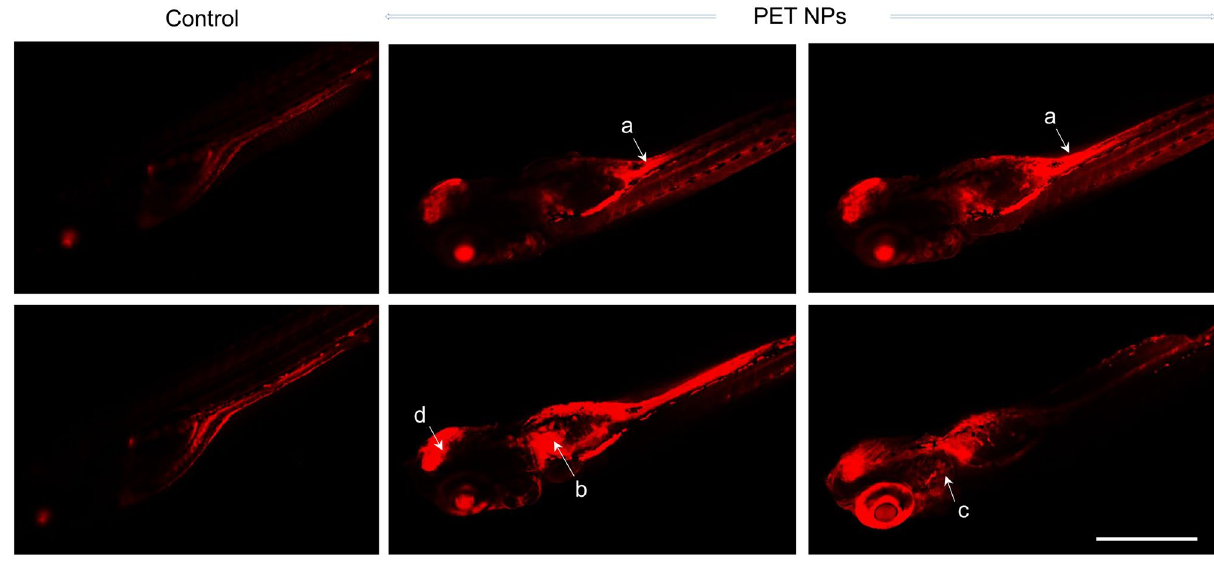
Figure 4. Representative Fluorescent confocal images (successive slices) showing the distribution of PET-NR nanoparticles in the body of zebrafish embryos (96 hpf) that were exposed to 100 ppm PET-NR nanoparticles for 24 h as compared to embryos treated with only NR (control). As can be noticed, nanoparticles are accumulated at various locations including intestine (a), pronephric duct/kidney (b), liver (c) and brain. Images were acquired using inverted laser-scanning confocal microscope (Leica DMi8 / TL LED, Leica Microsystems CMS GmbH). Scale bar: 1 mm.